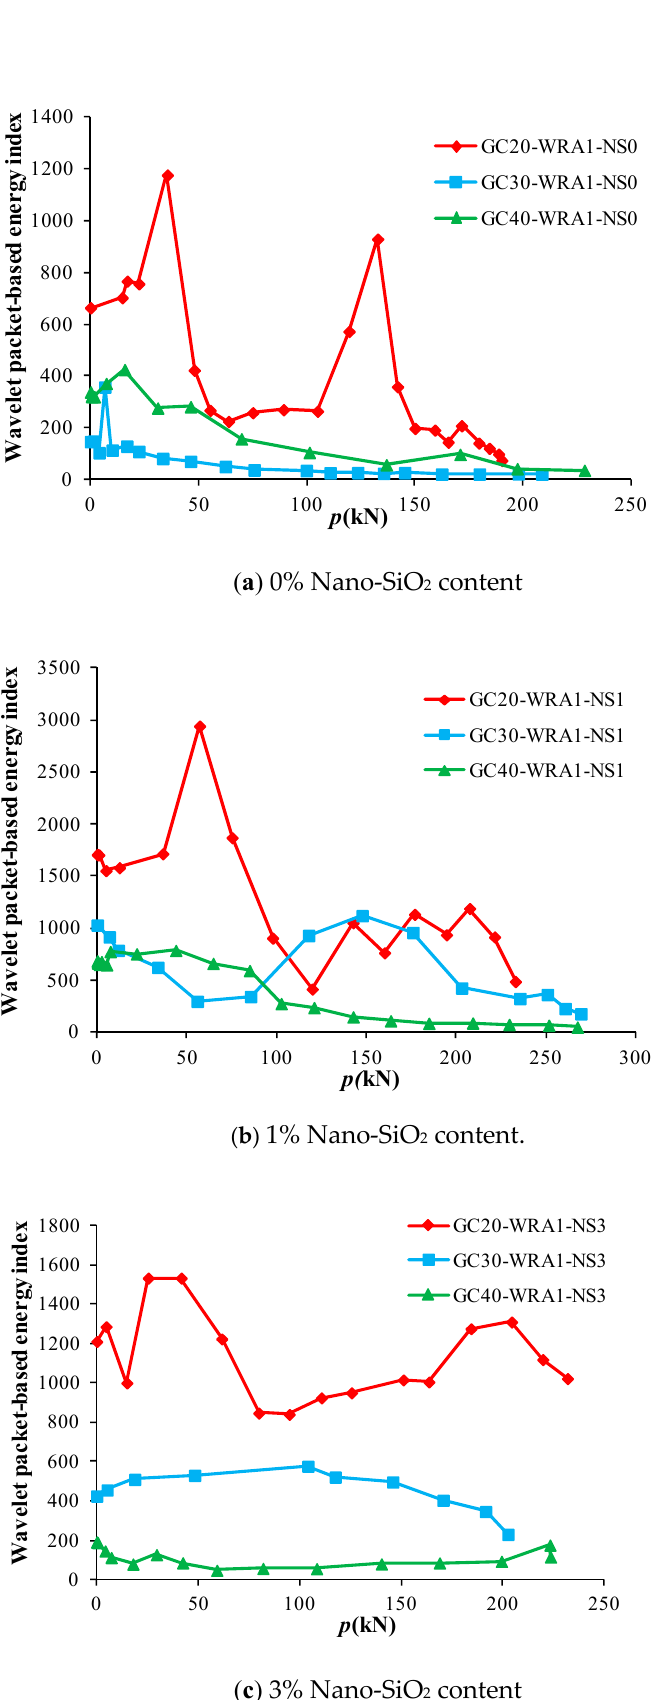
Figure 13. Load–energy index curves of superplasticizer-added specimens at different concrete grades.